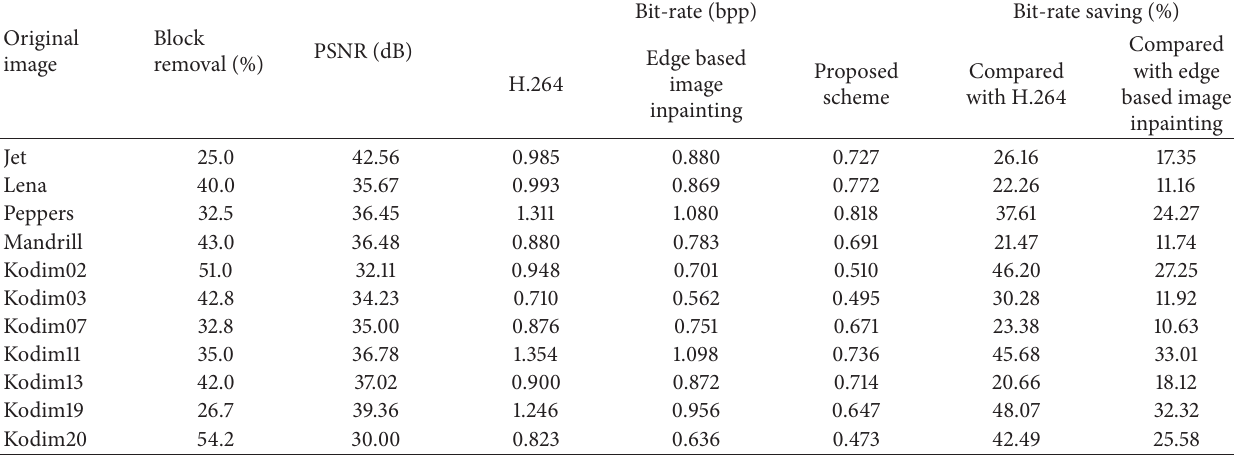
Table 2: Bit rate savings of proposed scheme compared to H.264/AVC intra and edge based image inpainitng method (QP =